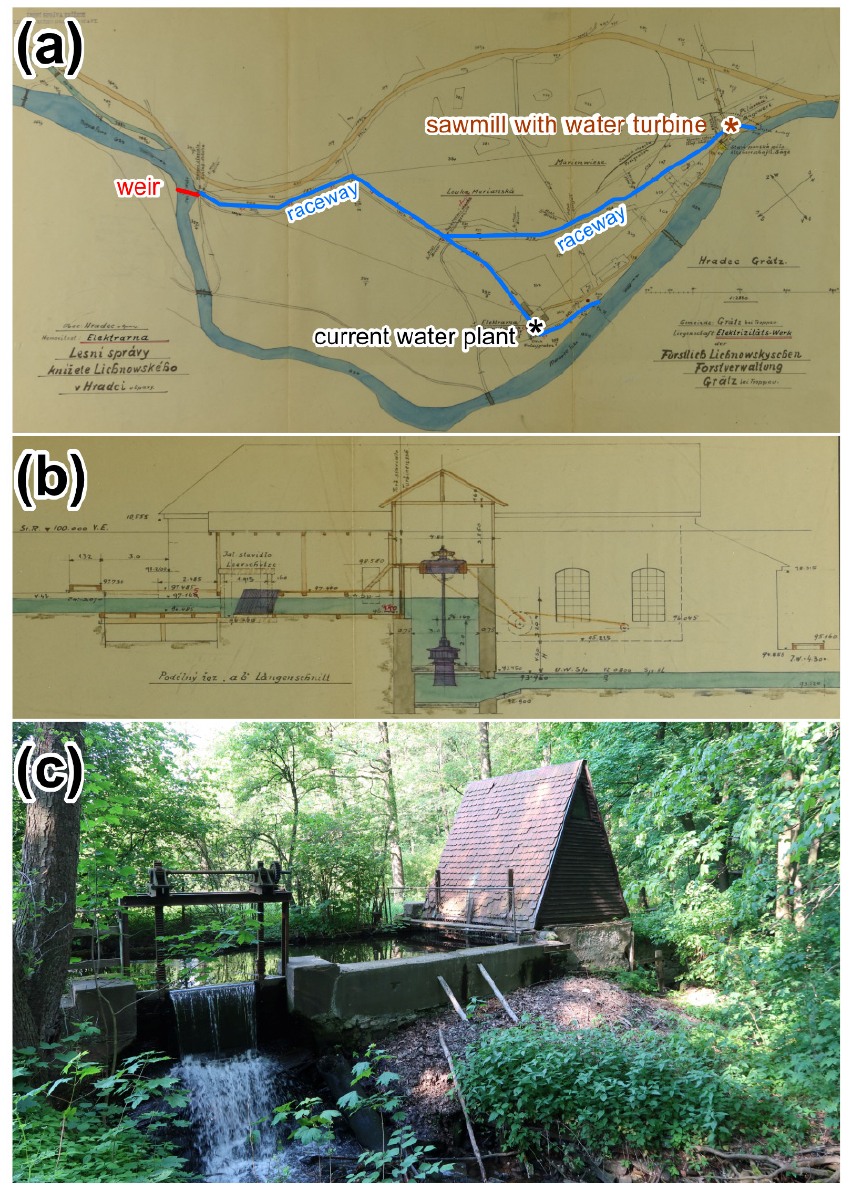
Figure 12. The Hradec nad Moravicí hydropower plant: ( a ) a historical situation plan from 1933; ( b ) a 1933 technical drawing of the former water turbine in the grain mill; ( c ) the current waterpower plant at the defunct grain mill (source: State District Archives in Opava, Opava District Office).